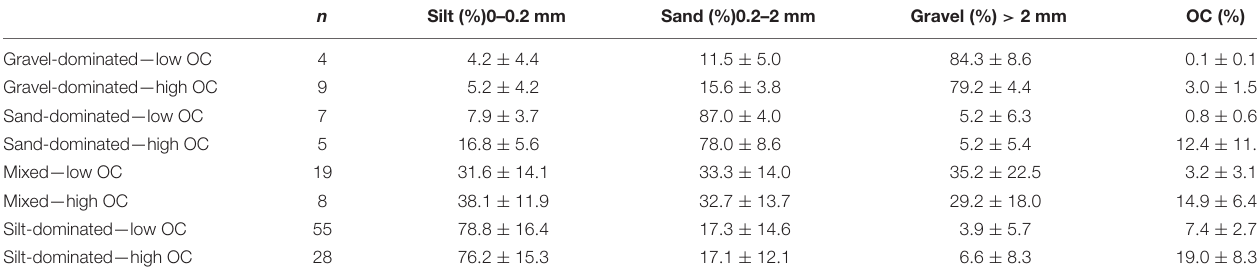
TABLE 1 | Categorization of sediments into eight types according to their prevailing grain-size and their organic content (OC). n